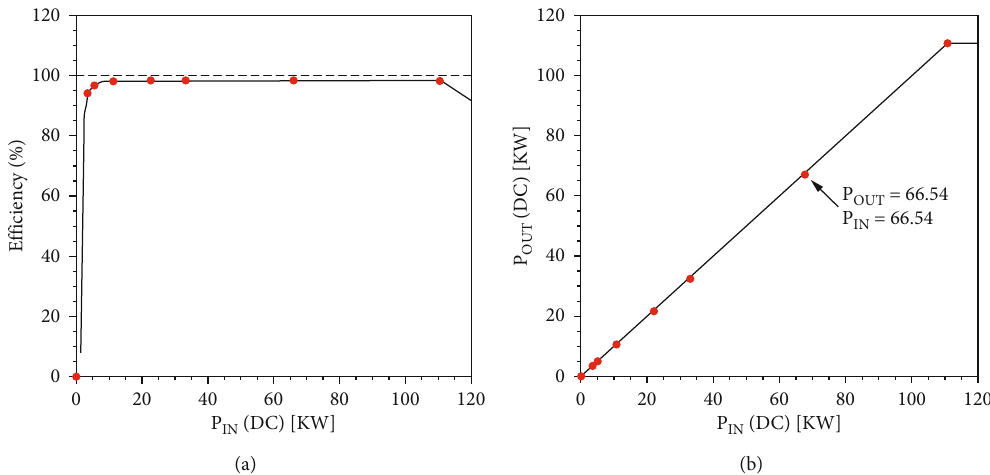
Figure 7: (a) E ffi ciency and (b) P